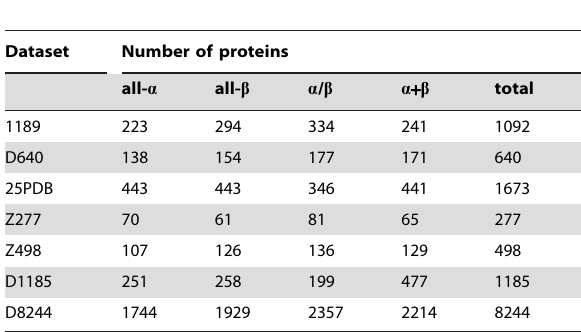
Table 1. Seven benchmark datasets used to train and test our predictor.